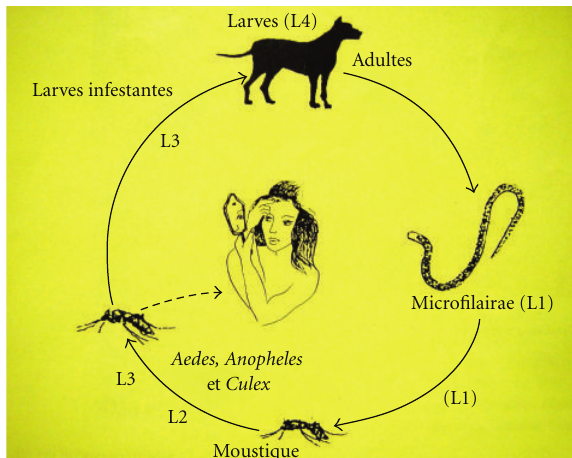
Figure 1: Dirofilaria repens cycle.